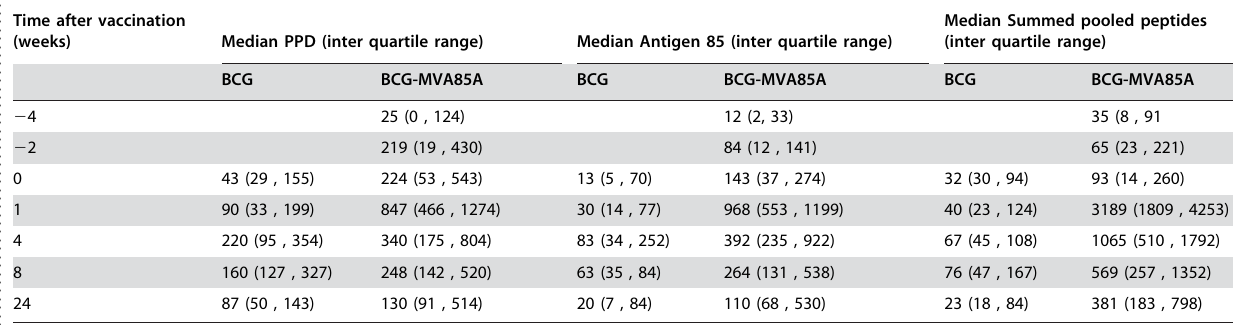
Table 4. Median (and inter quartile range) ELISpot responses to PPD, antigen 85 and summed pooled peptides in each vaccination group at each timepoint. .. ... .... ... ... .... ... ... .... ... ... .... ... ... .... ... ... .... ... ... .... ... ... .... ... ... .... ... ... .... ... ... .... ... ... .... ... ... .... ... ... .... ... ... . Time after vaccination (weeks)